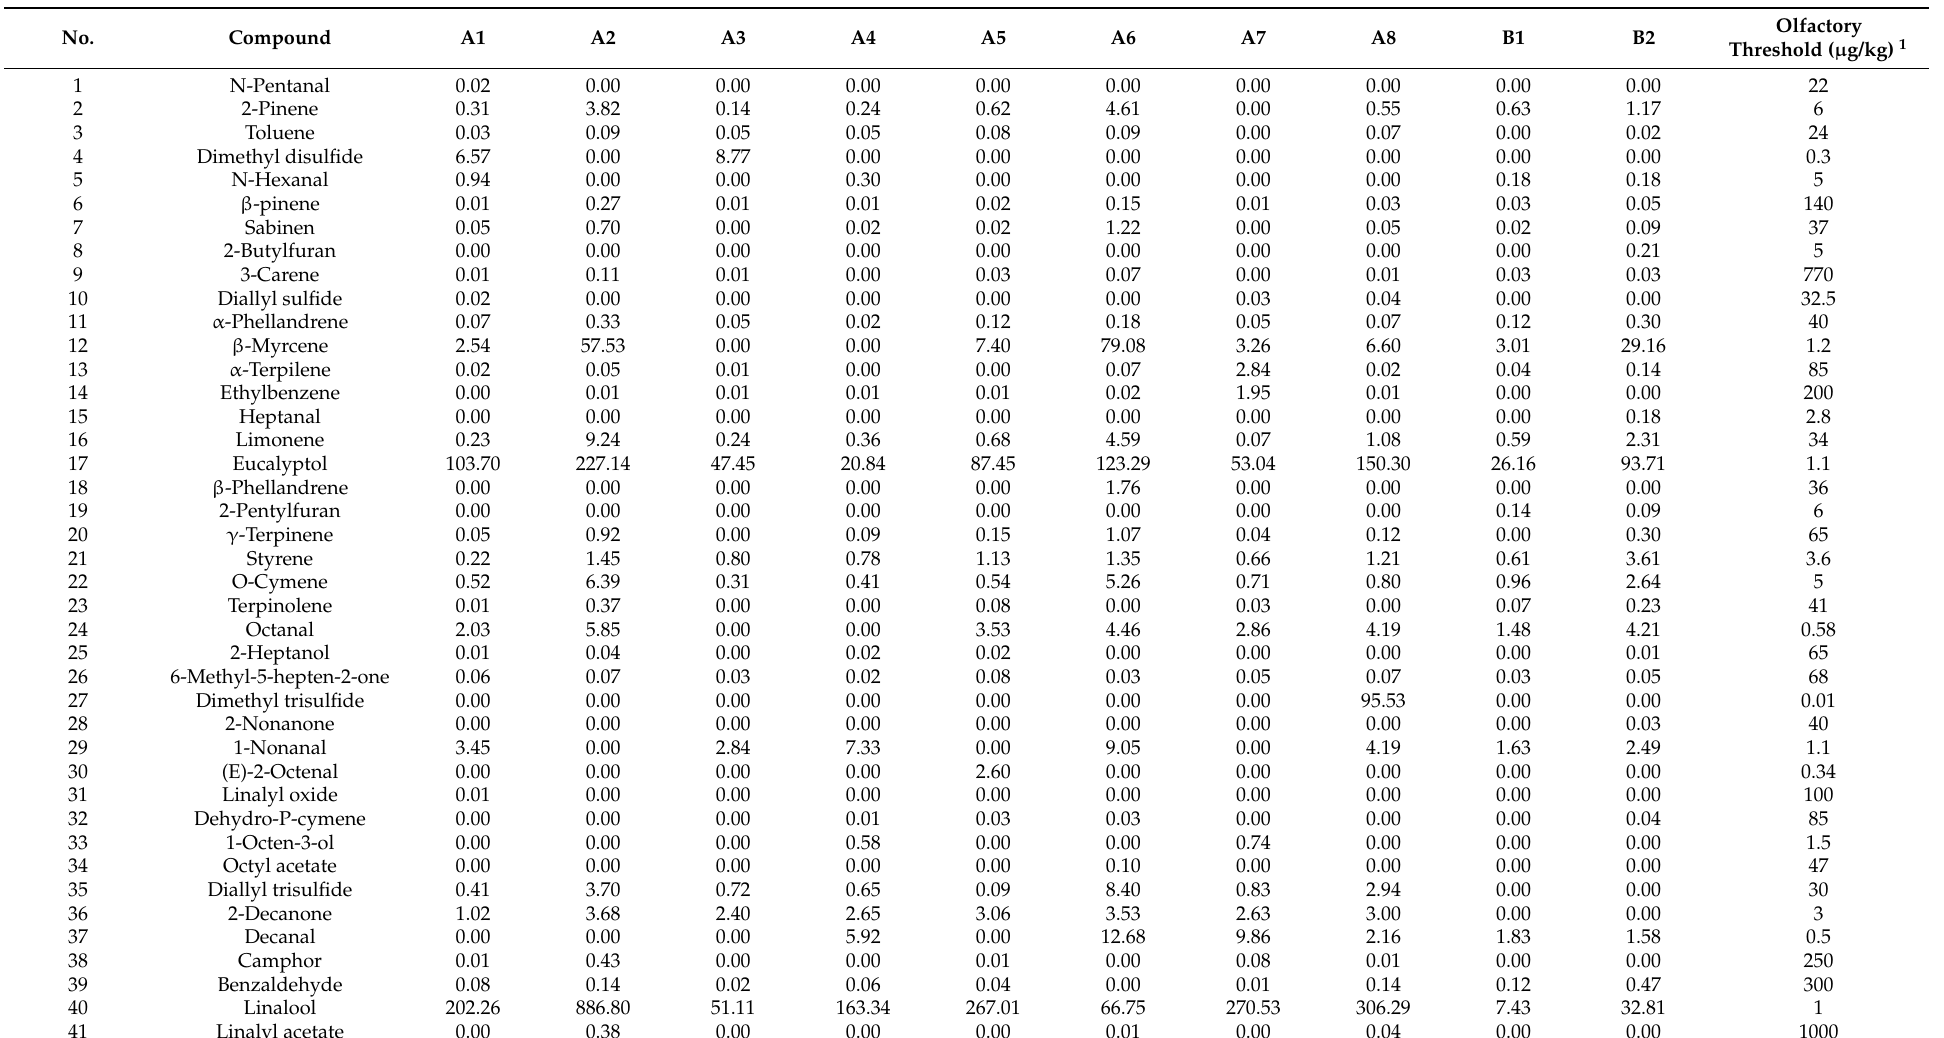
Table 4. The OAV value of volatile compounds in each